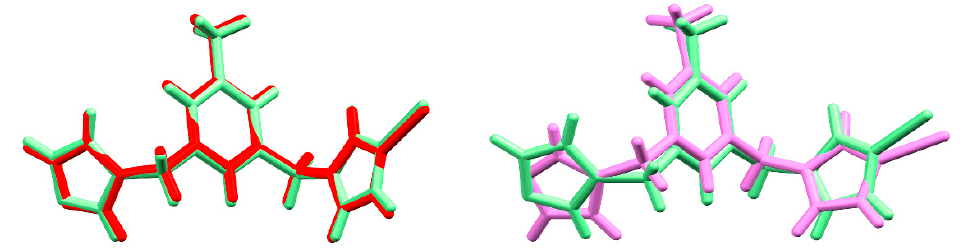
Figure 3. Overlays of silver (I) complexes 1 (green) and 2 (red) on the left (RMS deviation is 0.122 Å), and silver (I) complexes 1 (green) and 4 (pink) on the right (deviation is 0.939 Å).